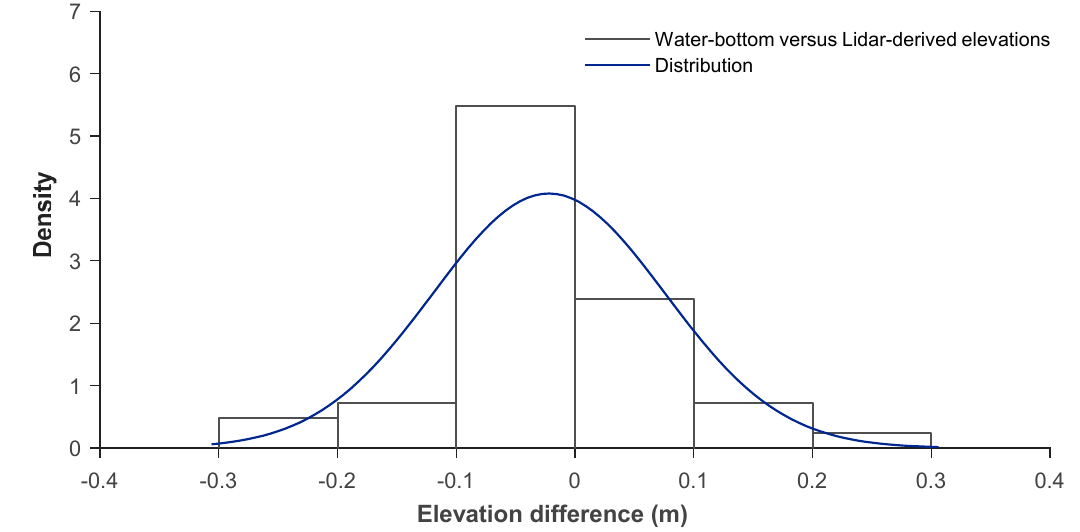
Figure 13. Distribution of GPS measured water-bottom elevations to Lidar-derived elevations. Mean error was − 0.01 m and we computed standard deviation at 0.08 m. As an average, adjusted R 2 = 0.929 indicated a very robust correlation (Table 4). Table 4. Comparison of water-bottom measurements to Lidar-derived elevations ( d Z = h L − h g ).